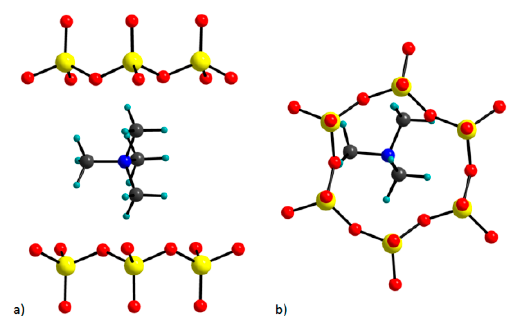
Further, the position of TMA cations in the interlayer space is similar to the one in the refined model in the work of Seidl and Breu (2005) [38]. That means that TMA cations are positioned in the middle of the interlayer space. Two of the methyl groups lie in the ab plane, whereas the remaining two methyl groups point up and down (Figure 6a) and they are centered in the ditrigonal hole (Figure 6b).